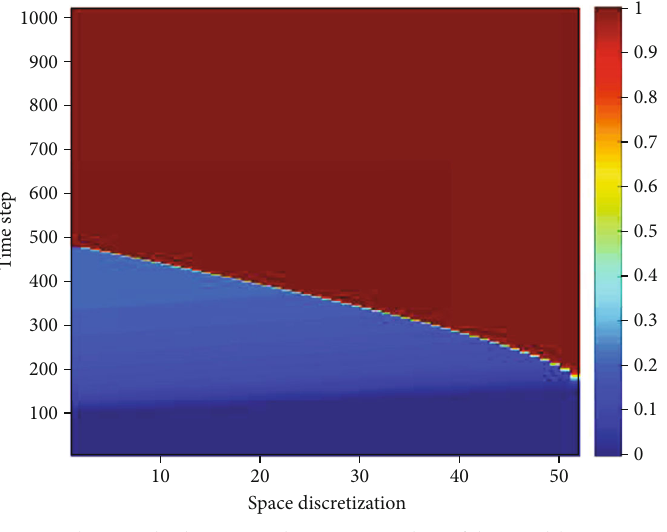
, I , I ) in the case of (a) and on ( S 1 2 3